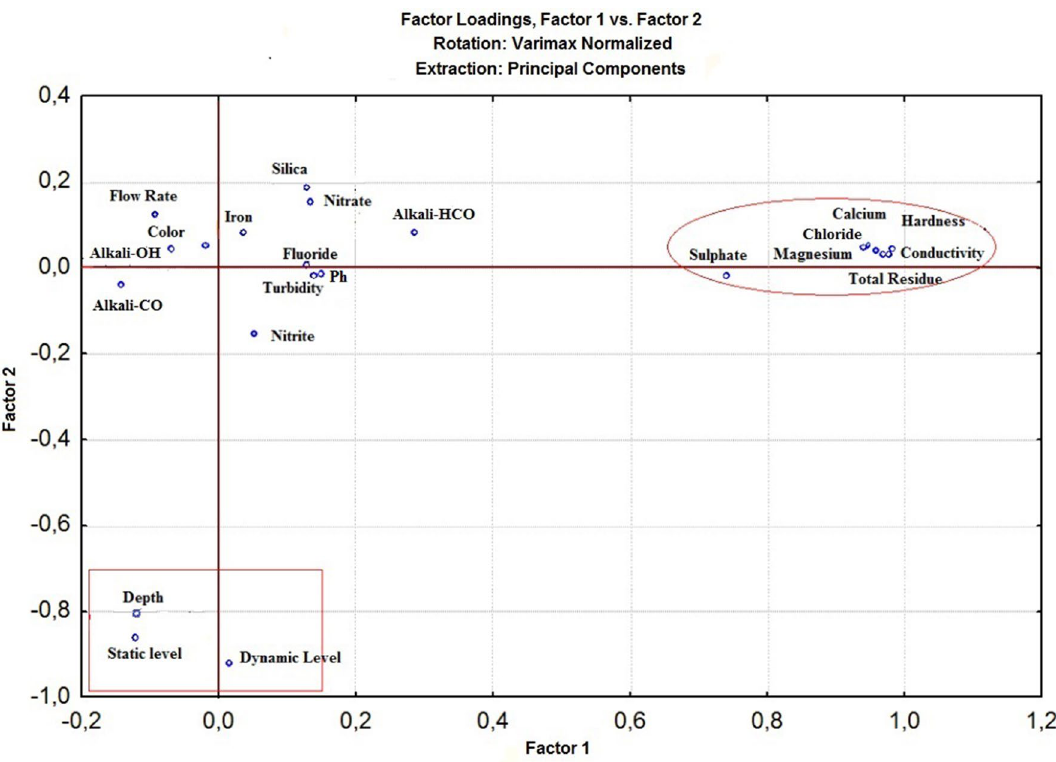
Figure 3. Graphical representation of factors F1 x F2 (Normalized Varimax Rotation), using Statistica, version 7.0 115 .